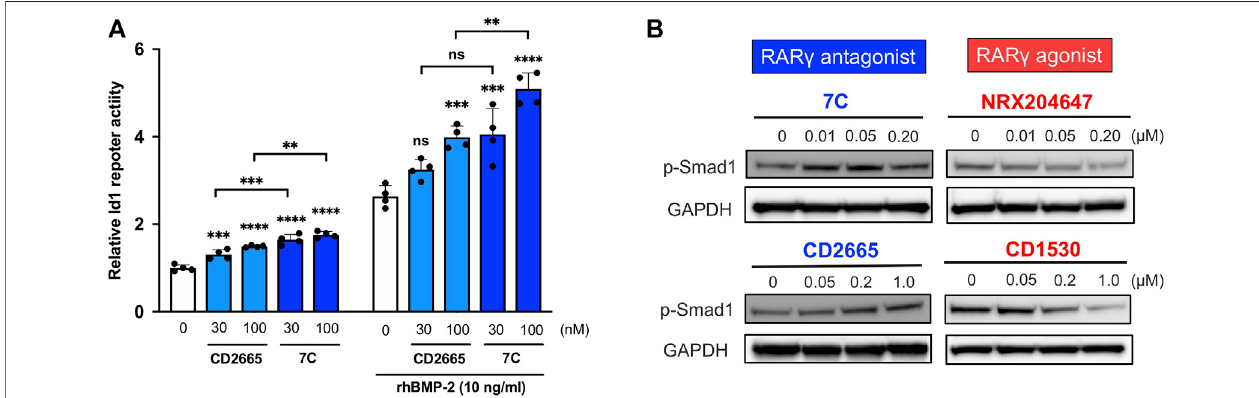
FIGURE7| EffectofRAR γ antagonistsandagonistsonBMPsignaling. (A) Id1-lucreporteractivityinATDC5cellstreatedwithRAR γ antagonists(CD2665and7C) withorwithout10 ng/mlrhBMP-2. n =4pergroup.** p < 0.01,*** p < 0.001,**** p < 0.0001,andns,notsigni fi cant. (B) Immunoblottinganalysiswithp-Smad1antibody. The ATDC5 cells were treated with BMP-2 and increasing concentrations of RAR γ antagonists (CD2665 and 7C) and RAR γ agonists (NRX204647 and CD1530). The cell lysates were prepared 45 min after treatment and subjected to immunoblot analysis for p-Smad1 and GAPDH.